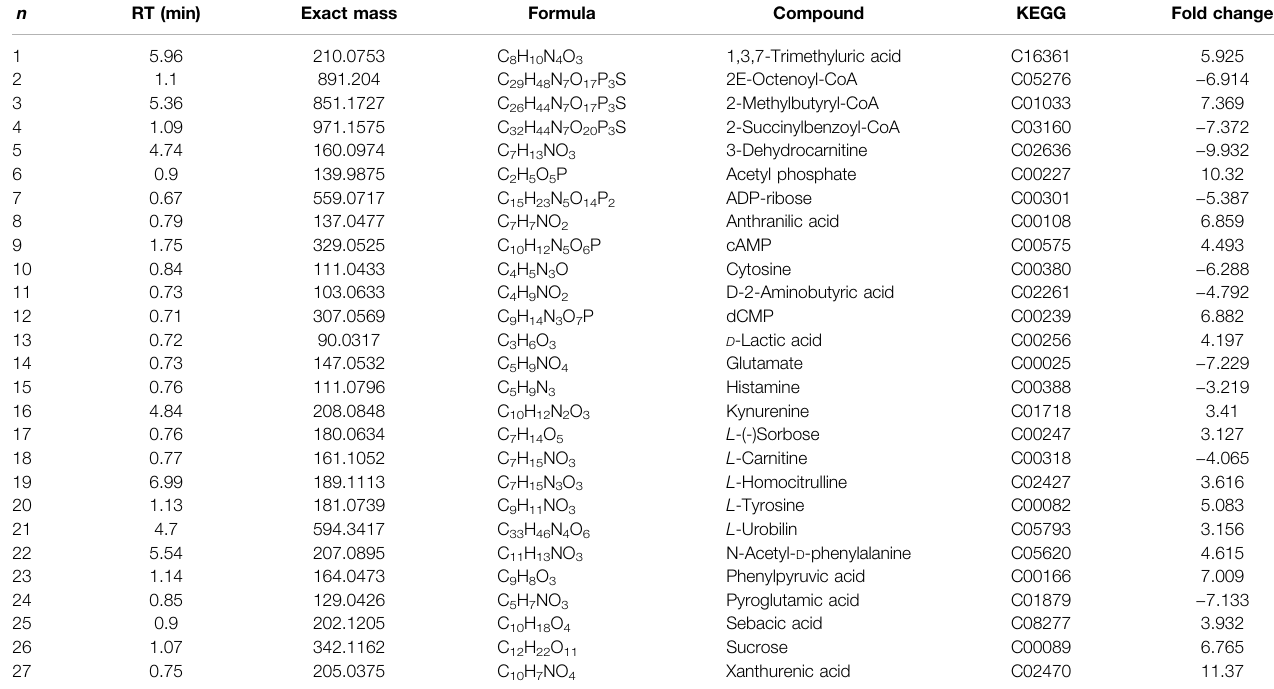
TABLE 2 | Characterization of terminal metabolites in MRSA bio fi